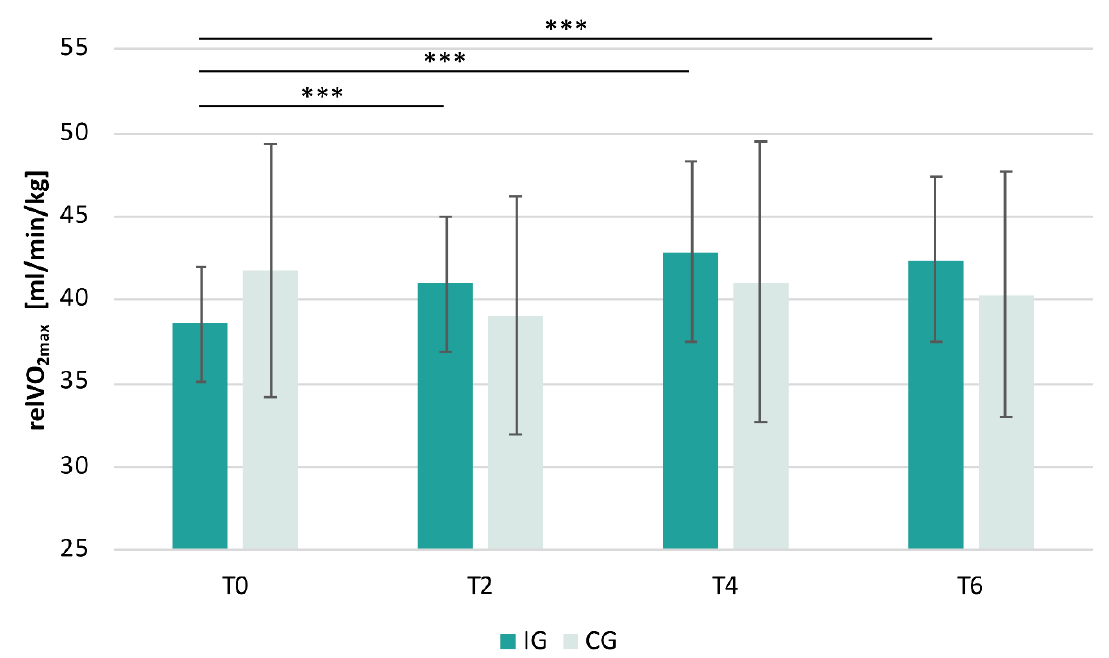
Figure 2. Change of relVO 2max over time in IG and CG. Mean ± standard deviation; number of sub-